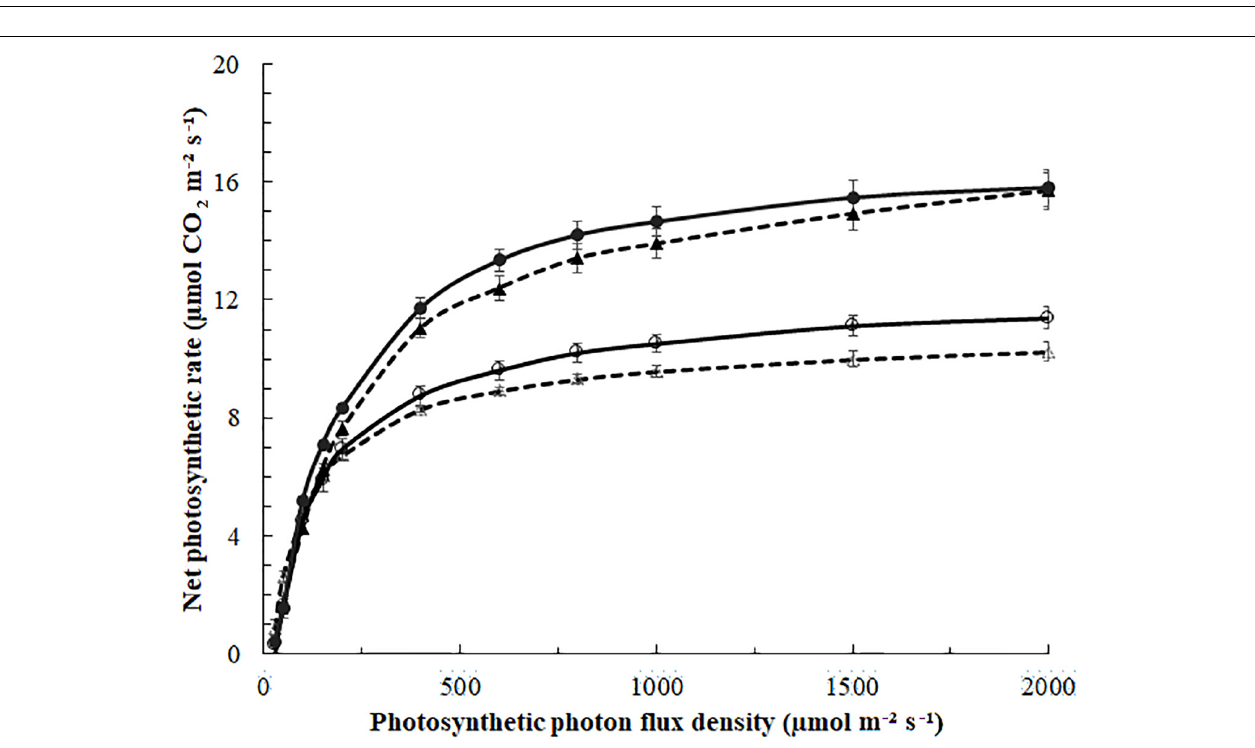
FIGURE 3 | Photosynthesis light-response curves of blackberry leaves exposed to 0 ( (cid:49)